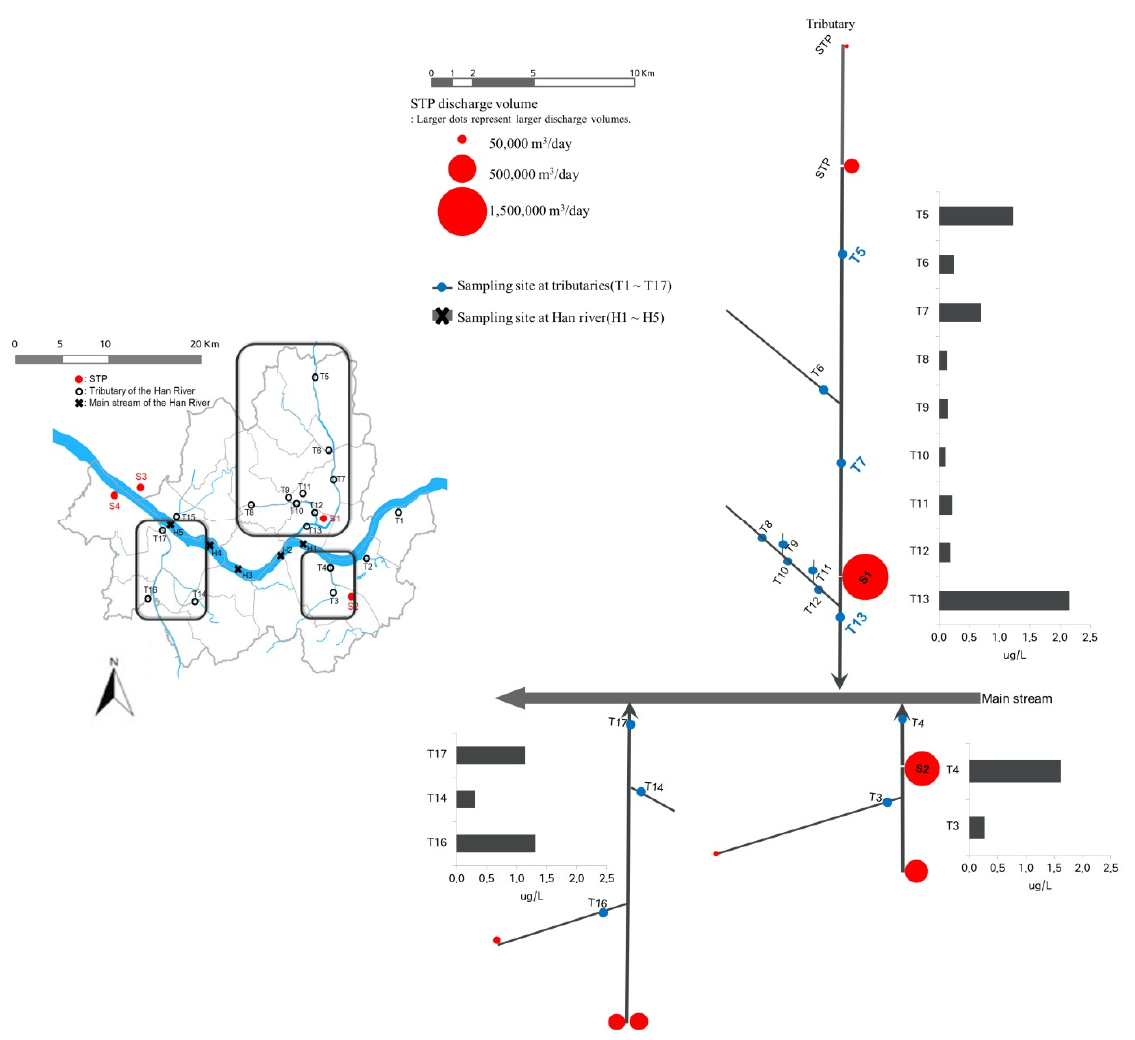
Figure 4. The location of the sampling site in the tributaries and the Han River basin and the average concentration of SMFs at each tributary (red circles represent the effluent volume of STP).